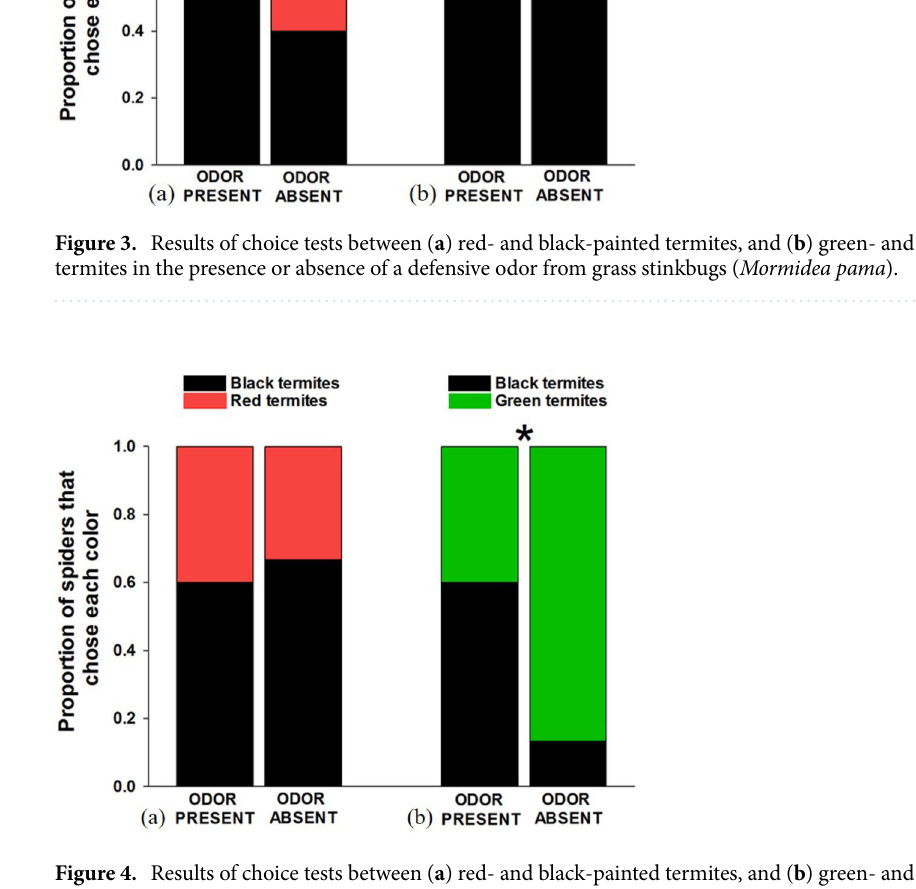
Experiment 3: Color choice tests in the presence/absence of odor from Asian ladybird bee- tles. Red versus black tests. The presence or absence of the beetle odor had no effect on color preferences between red and black termites (n = 30; 6 female, 14 male, 10 juvenile; X 2 = 0.144, p = 0.704; Fig. 4a). There was no evidence of color biases when the odor was either absent ( X 2 = 1.700, p = 0.192) nor present ( X 2 = 0.604, p = 0.437). When the odor was present, the spiders were less likely to direct their first orientations towards red compared to when the odor was absent ( X 2 = 5.170, p = 0.023). The presence of the odor did not affect the time that it took to orient to the first termite ( F 1,29 = 0.112, p = 0.740), the time to attack the first termite ( F 1,29 = 0.093, p = 0.763), nor the spiders’ time to evaluate prey before attacking ( F 1,29 = 0.392, p = 0.536). Neither sex/stage ( X 2 = 2.375, p = 0.305) nor size ( X 2 = 0.021, p = 0.885) affected spider color preferences. Green versus black tests. Unexpectedly, we found that spiders in the presence of the beetle odor were more likely to attack green termites when the odor was present compared to when it was absent (n = 30; 10 female, 8 male, 12 juvenile; X 2 = 7.459, p = 0.016; Fig. 4b). When the odor was absent, there was no evidence of color biases ( X 2 = 0.604, p = 0.437), but when the odor was present, spiders were more likely to attack green prey ( X 2 = 9.014, p = 0.003). The presence of the odor did not affect the color that the spider first oriented to ( X 2 = 1.208, p = 0.272), the time that it took to orient to the first termite ( F 1,29 = 0.435, p = 0.515), the time to attack the first termite ( F 1,29 = 0.930, p = 0.343), nor the spiders’ time to evaluate prey before attacking ( F 1,29 = 0.611, p = 0.441).